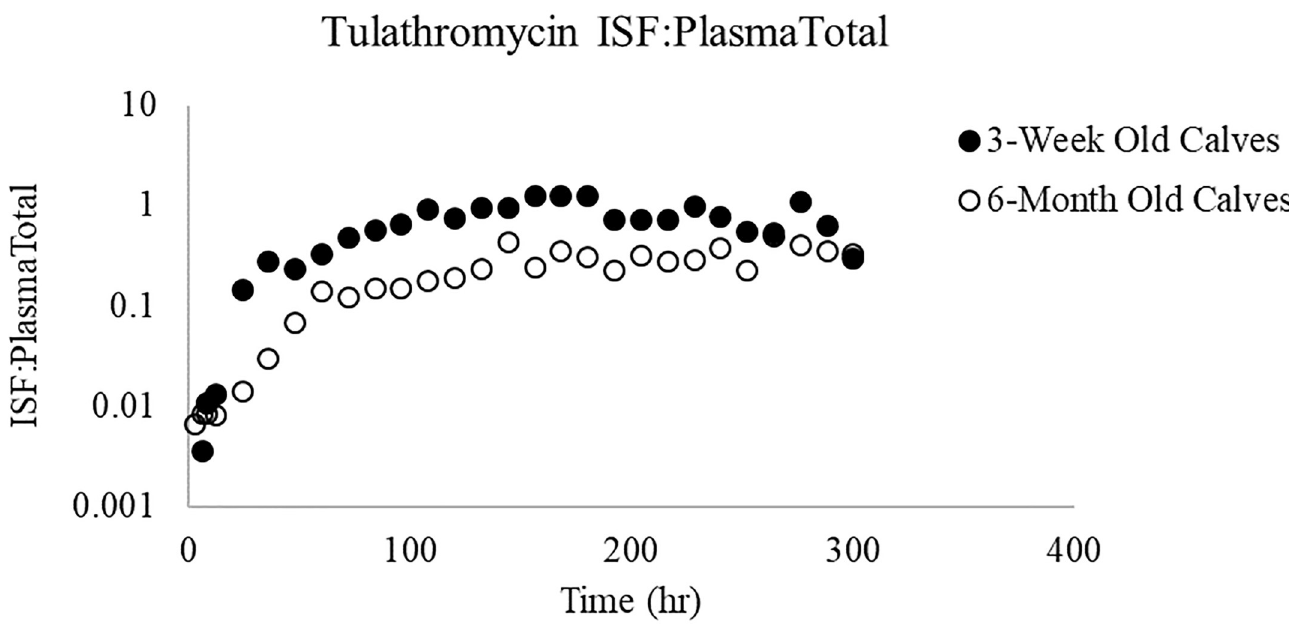
Fig 6. ISF:Plasma Total ratios for tulathromycin. Ratios comparing unbound drug in ISF to total drug (bound and unbound) in plasma.